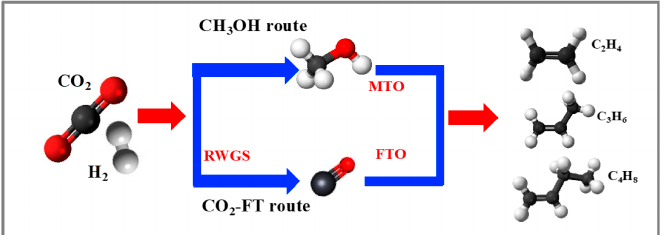
Figure 14. General scheme for the synthesis of DME by direct hydrogenation of CO 2 with hybrid or bifunctional catalysts Reaction scheme for CO 2 hydrogenation to light olefins [328].